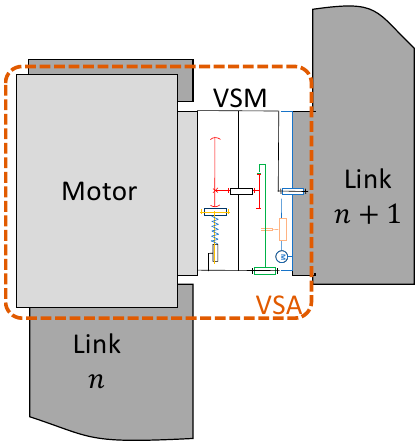
Figure 1. Variable stiffness actuator (VSA) including the variable stiffness safety-oriented mechanism (V2SOM).